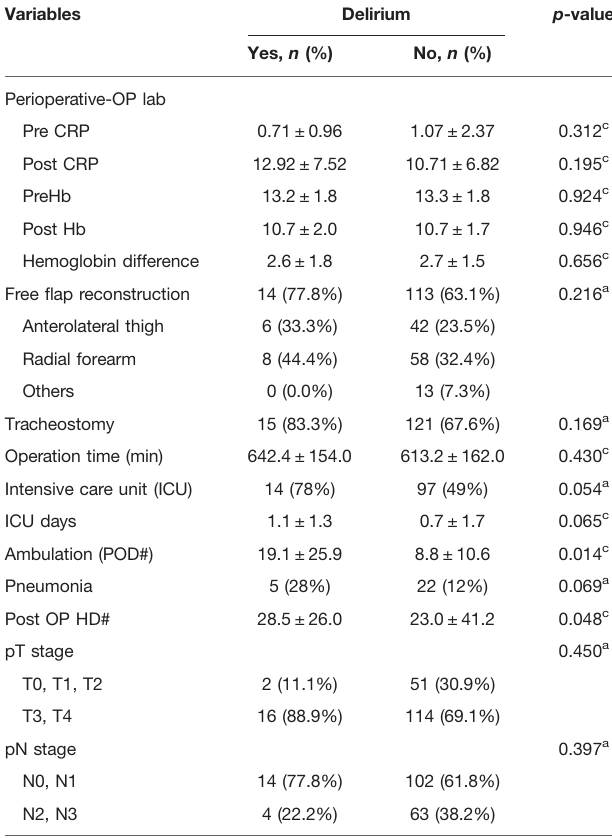
TABLE 2 | Univariate analysis of operative and postoperative fi ndings related to delirium.